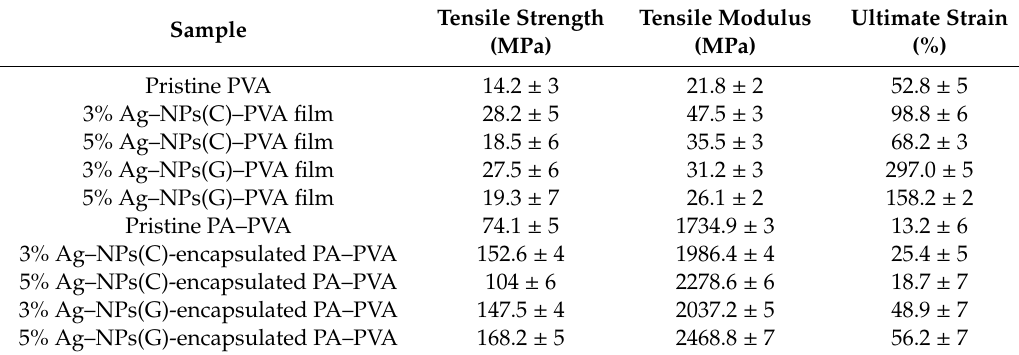
Table 2. Mechanical properties of various as-prepared